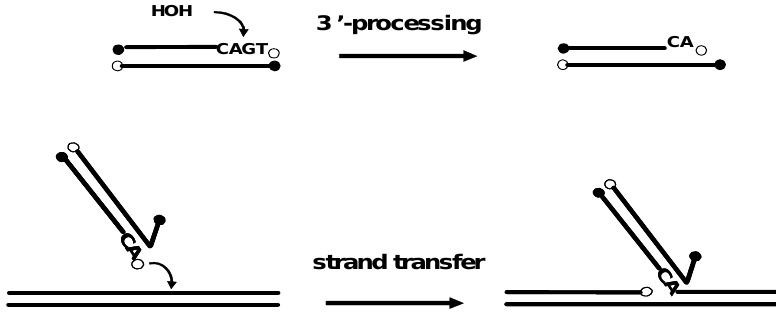
Figure 1. Schematic representation of the two integrase catalytic reactions (3'-processing and strand